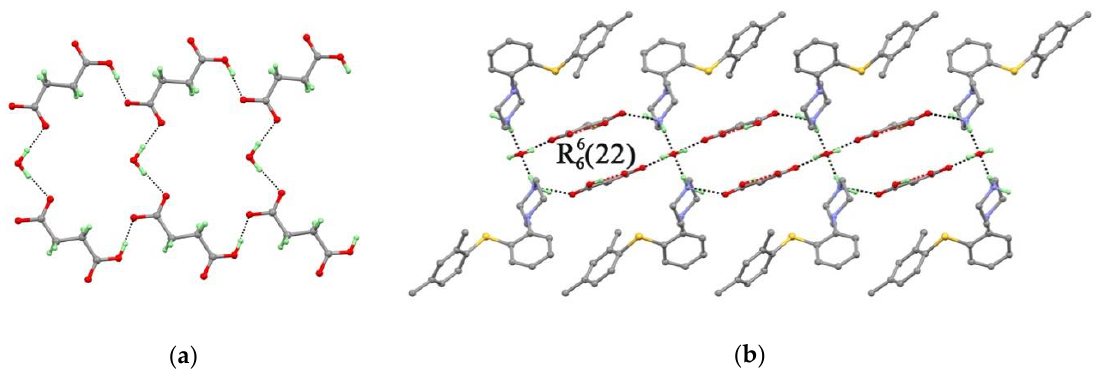
Figure 4. ( a ) Two SUA anions and one water molecules form a sheet-like structure through O5-H5A···O4 and O2-H2···O3 hydrogen bonds; ( b ) The R 6 N1 + -H1A···O1 and N1 + -H1B···O5 hydrogen bonds.